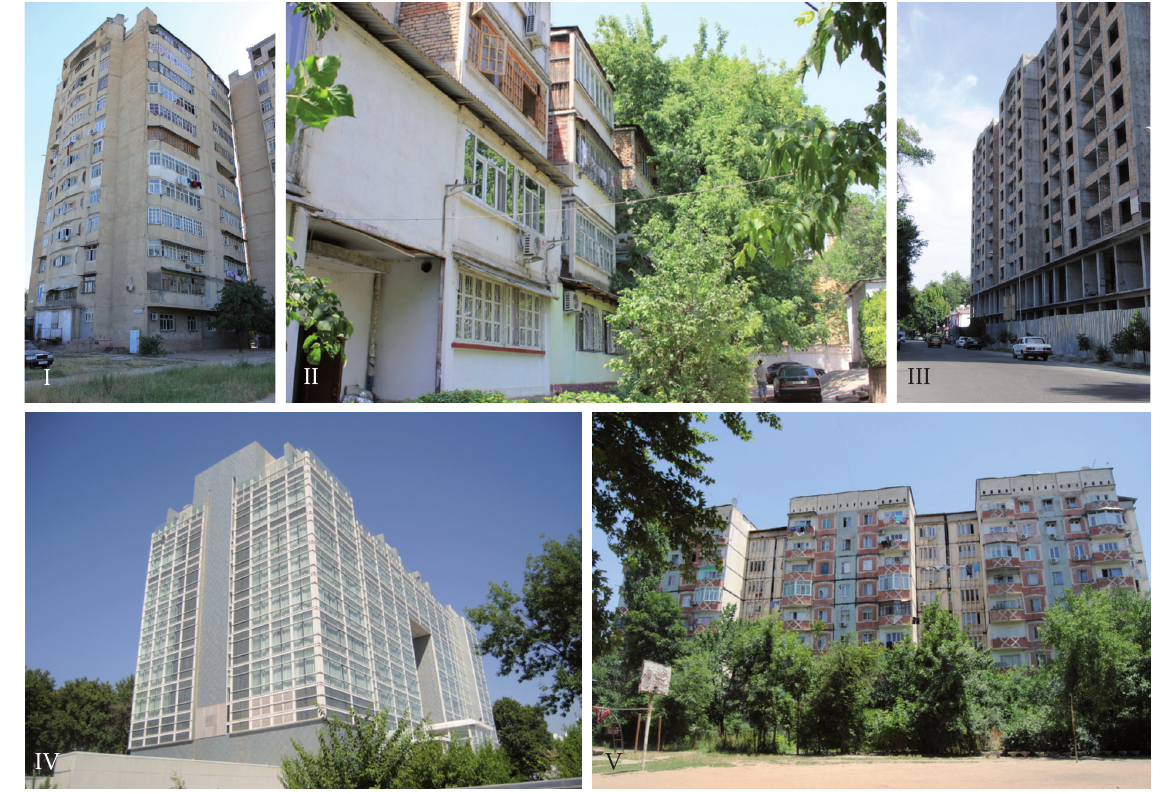
Figure 2. Photos of the 5 buildings in Dushanbe where ambient vibration measurements were performed. (I) 12 story monolitic RC build- ing, (II) 4 story confined masonry building, (III) 12 story RC dual system building under construction, (IV) Serena Hotel and (V) 9 story re- inforced large panel precast concrete building.